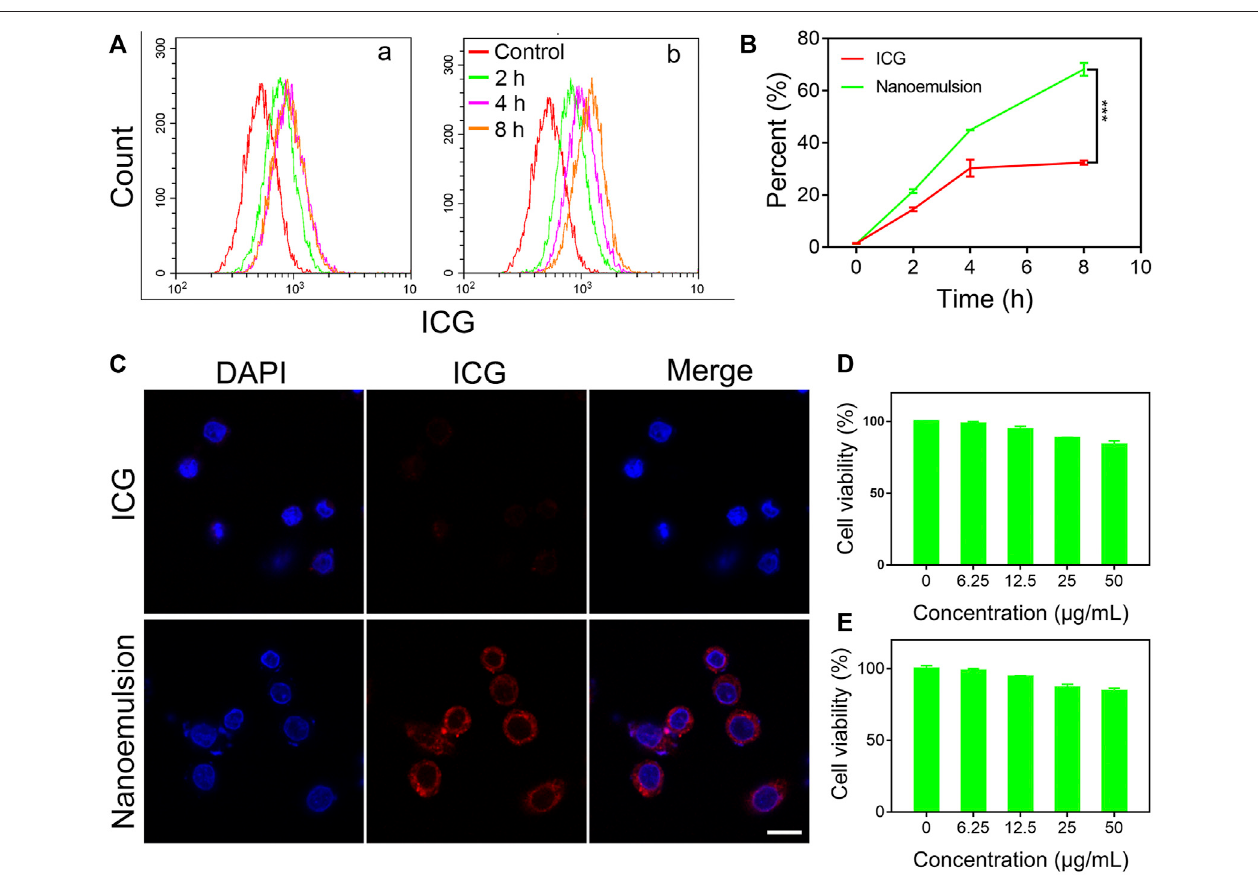
FIGURE2|(A) Flowcytometrypro fi les, (B) quantitativeanalysis,and (C) CLSMimagesofICGandnanoemulsioninternalizationbyHepG2cells.Cellviabilityof (D) LO2 cells and (E) HepG2 cells treated with nanoemulsion at different ICG